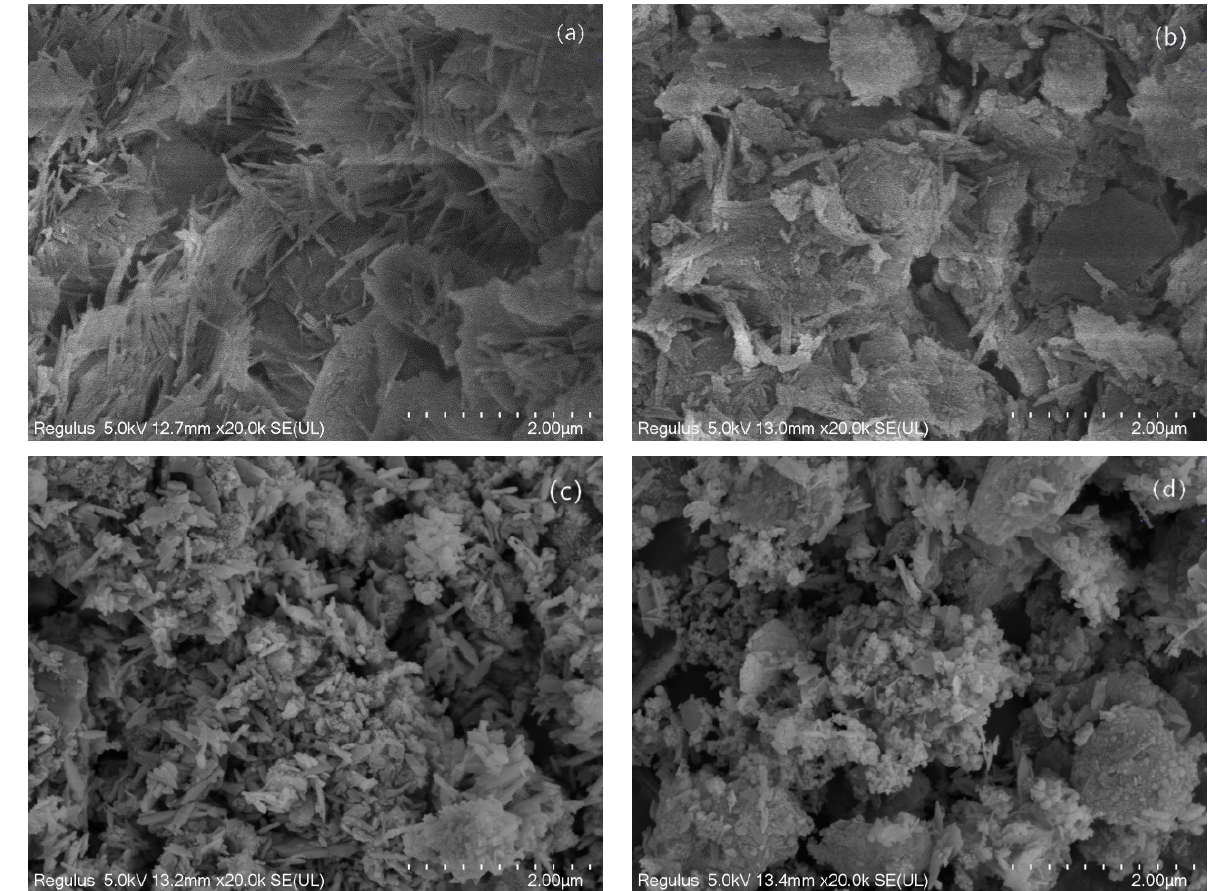
Figure 2. SEM photographs of ( a ) acid modified attapulgite (ATP), ( b ) Acid modified ATP, ( c ) Fe-Mn-Cu and ( d ) Fe-Mn-Cu@ATP.